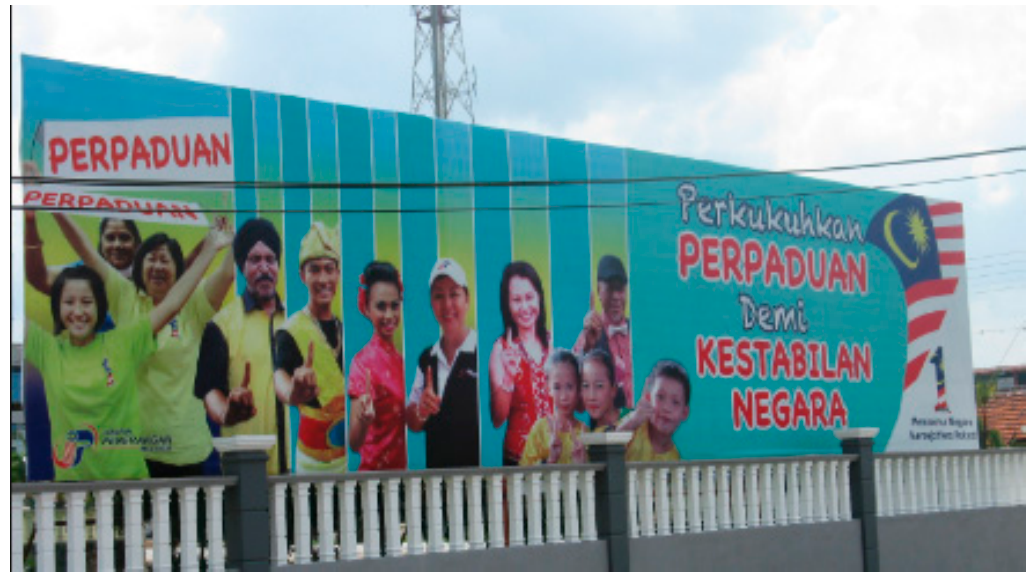
Figure 1. Perkukuhkan Perpaduan Demi Kestabilan Negara billboard.